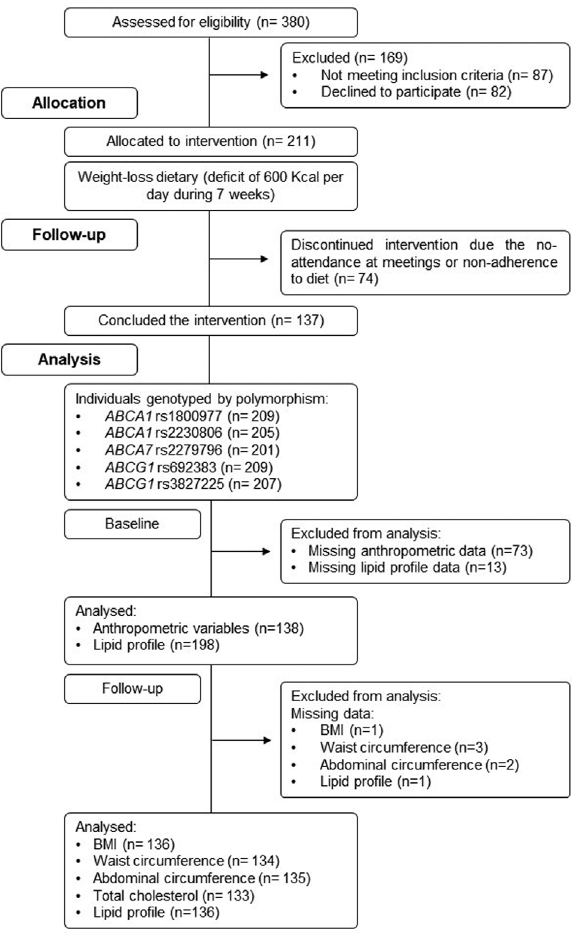
Figure 1 - Consort diagram of the study design and